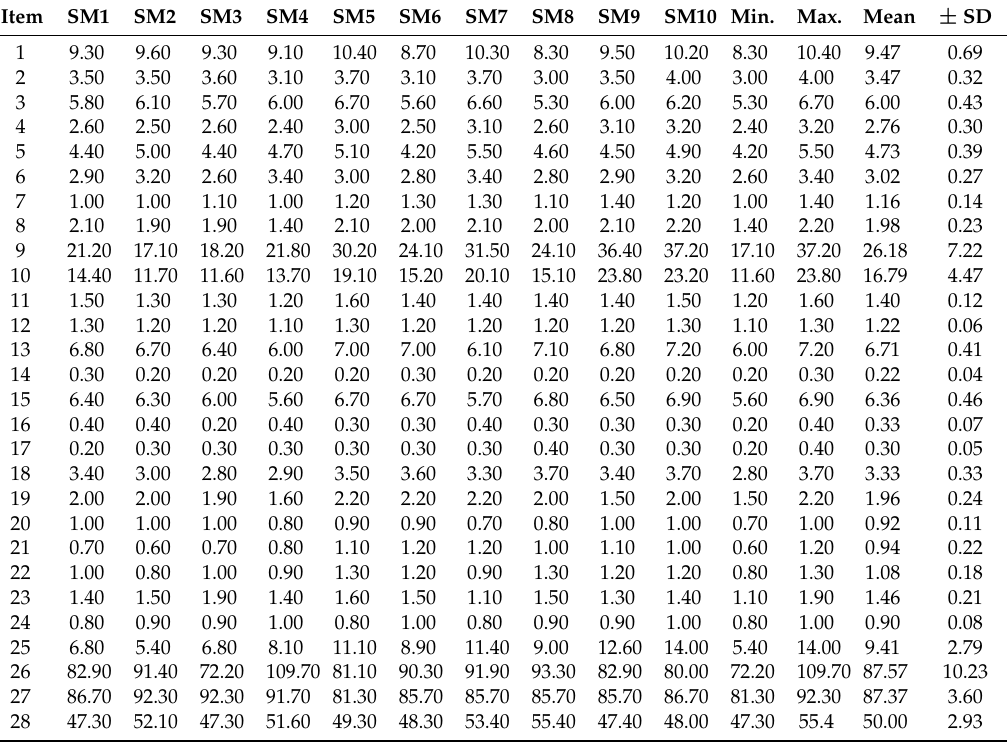
Table 2. Morphometry of the skull and mandible (SM) of the common